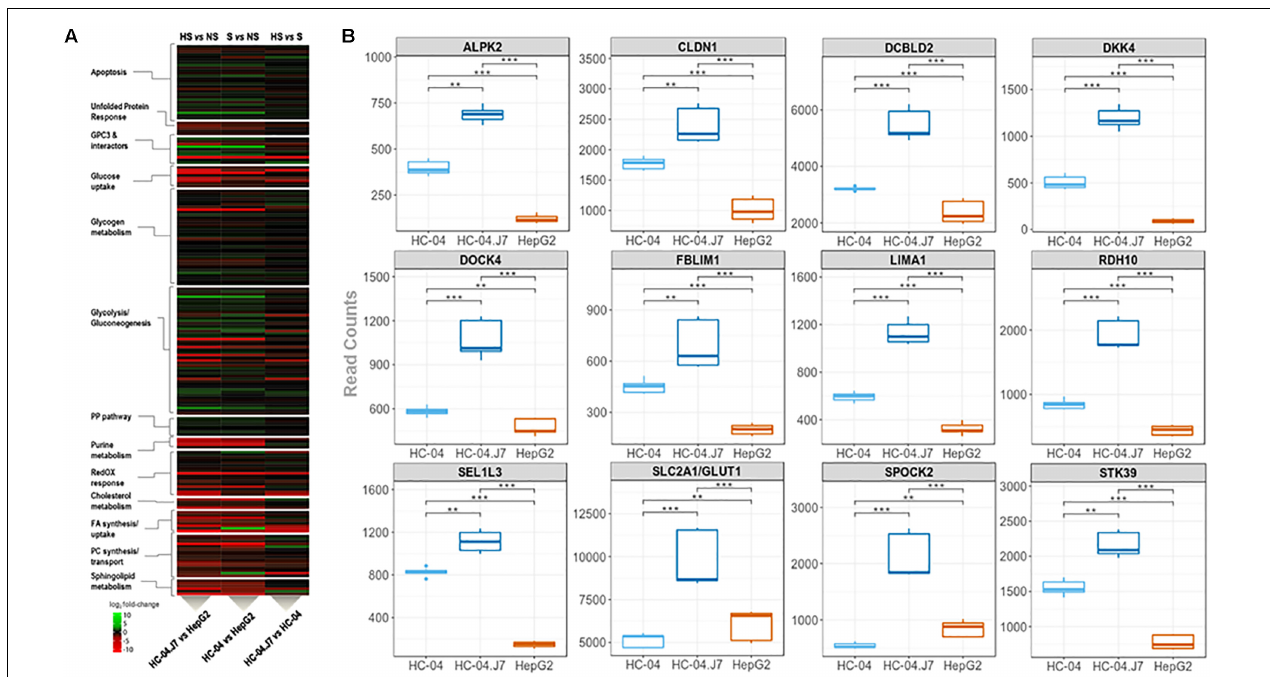
FIGURE 4 | Transcriptomic mining reveals pathways and genes that partition hepatocarcinoma lines that are (i) highly susceptible, HC-04.J7, (ii) susceptible, HC-04 (parental), or (iii) non-susceptible, HepG2, to P. falciparum sporozoite infection. (A) Heatmap displaying the relative transcript reads of various transcripts comparing HC-04.J7 (highly susceptible, HS) and HepG2 (non-susceptible, NS; left); HC-04 (susceptible, S) and HepG2 (center); and HC-04.J7 and HC-04 (right). (B) Boxplot analyses for a subset of genes through the transcriptomic profiling of the three cell lines. Read counts are indicated along the y -axes for each comparison. P -values were calculated using a two-sided Mann–Whitney U test. ∗ P < 0.05, ∗∗ P < 0.01, ∗∗∗ P < 0.001.